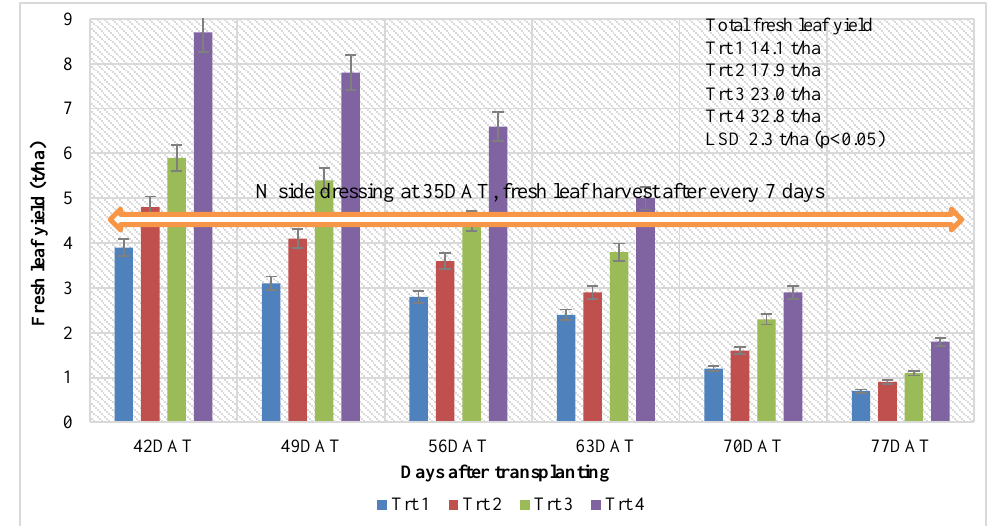
Figure 3b . Fresh rape leaf yield responses over the growing seasons after N fertilizer applications (2015)